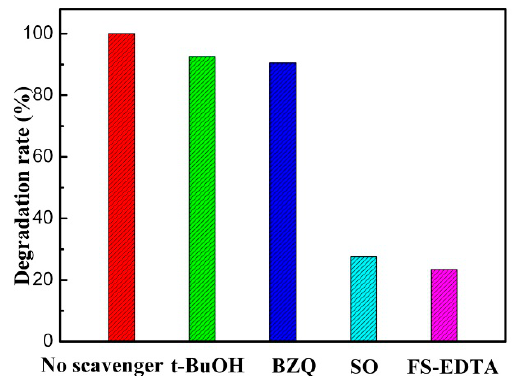
Figure 9. Effect of various scavengers on the visible-light photocatalytic performance of over the ZSC1.5 photocatalyst.